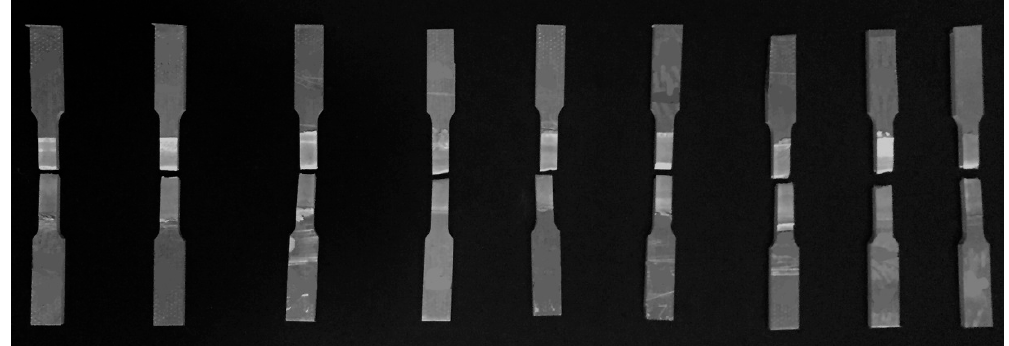
Figure 7. Tensile test specimens after uniaxial tensile testing.